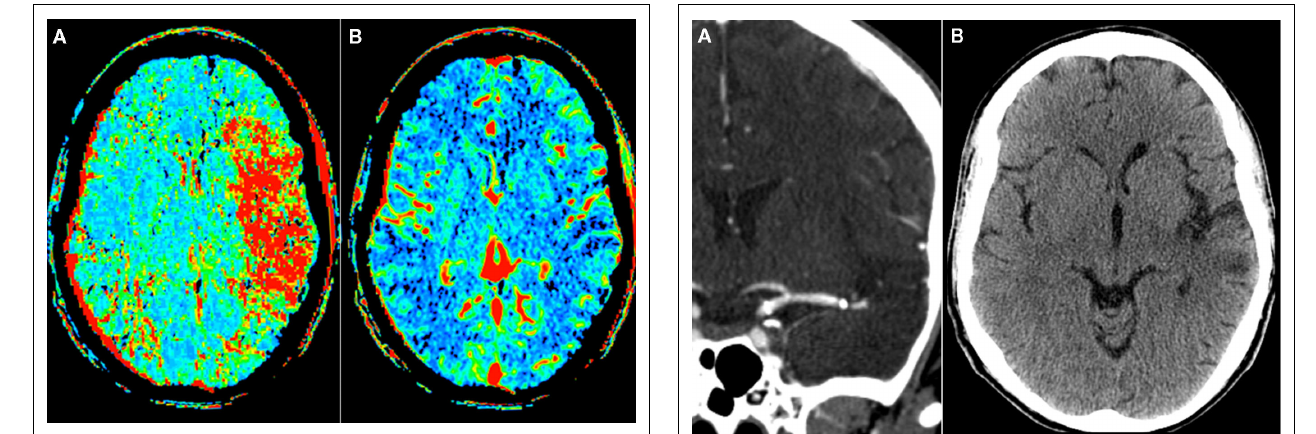
FIGURE 3 | Computed tomography (CT) angiography demonstrating patency of the stent in a 6-month follow-up (A). Non-contrast CT demonstrates a small left MCA territory infarct (B)